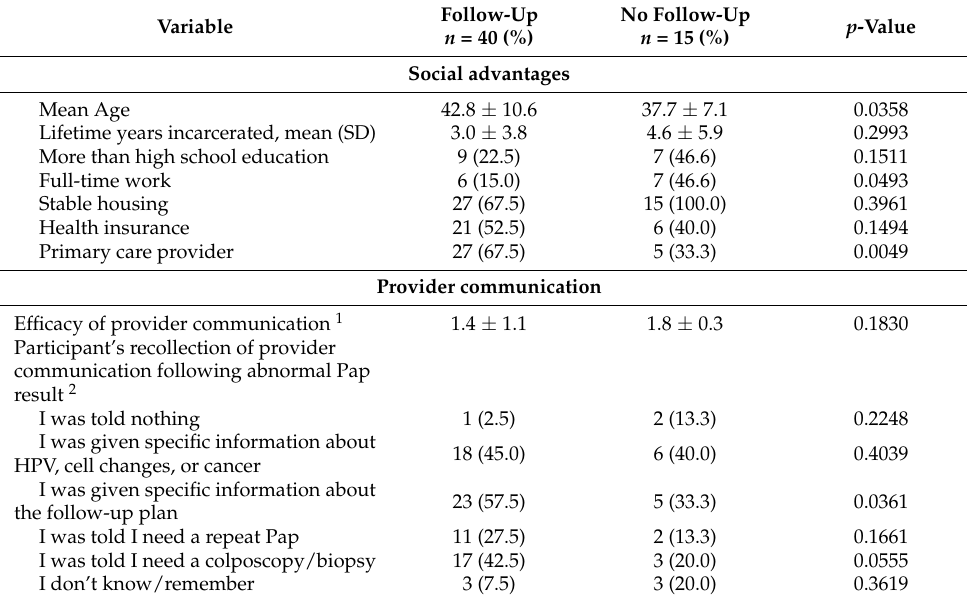
Table 3. Variables associated with abnormal Pap follow-up among criminal-legal involved women.